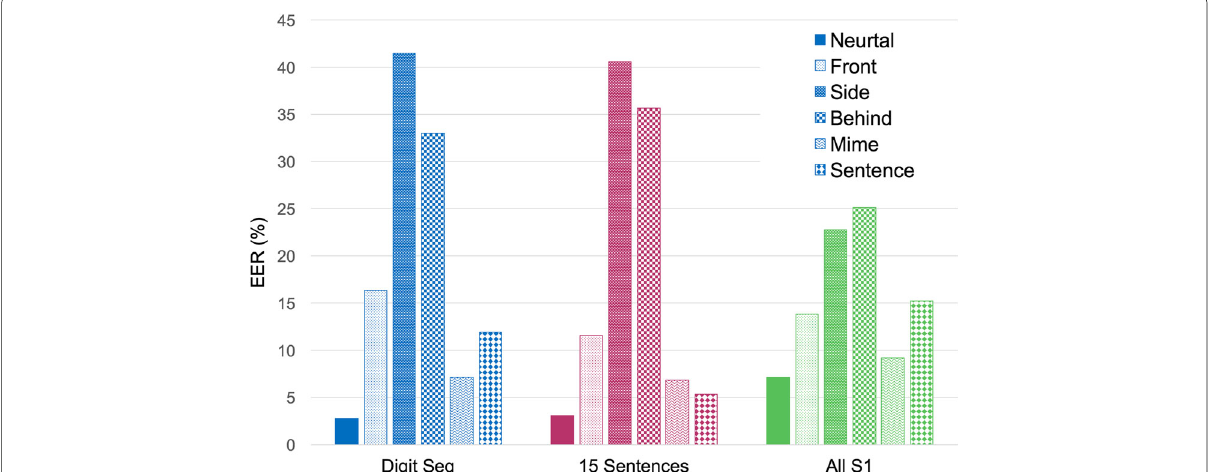
Fig. 11 Results for the FAVLIPS dataset using traditional LBBA approach from [10]. EER against 3 different enrolment models per person: using digit sequences only (blue), sentences only (pink), and all data from Session 1 (green). Each model was tested against 6 different authentication sequences, shown in different